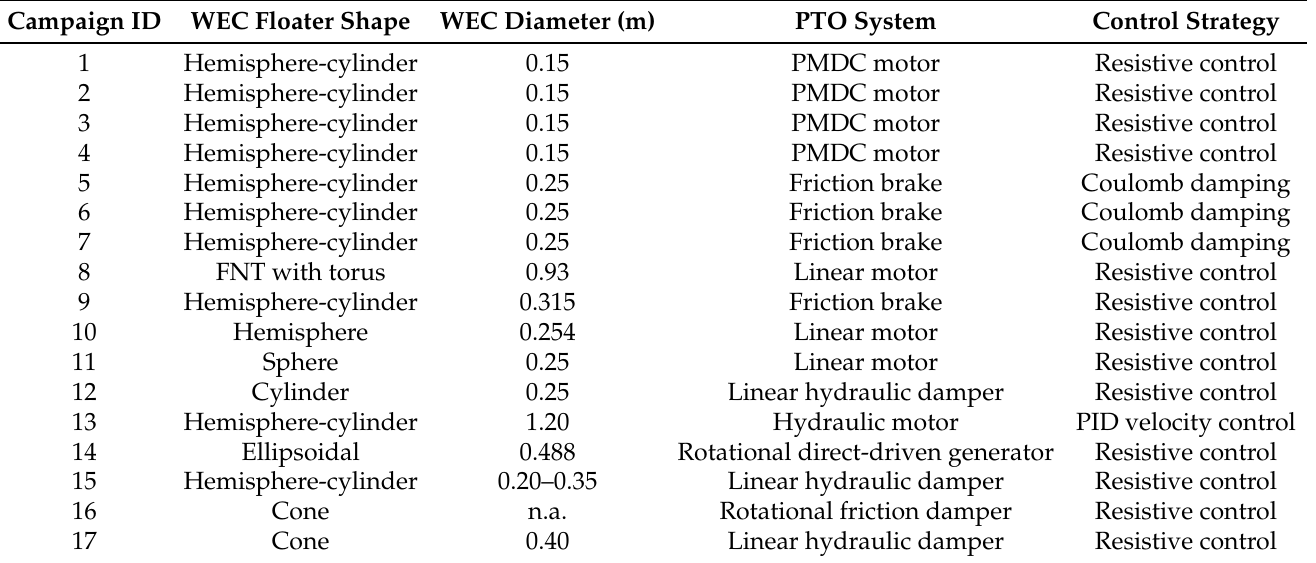
Table 2. Overview of the WEC design characteristics of the WEC array experimental campaigns of Table